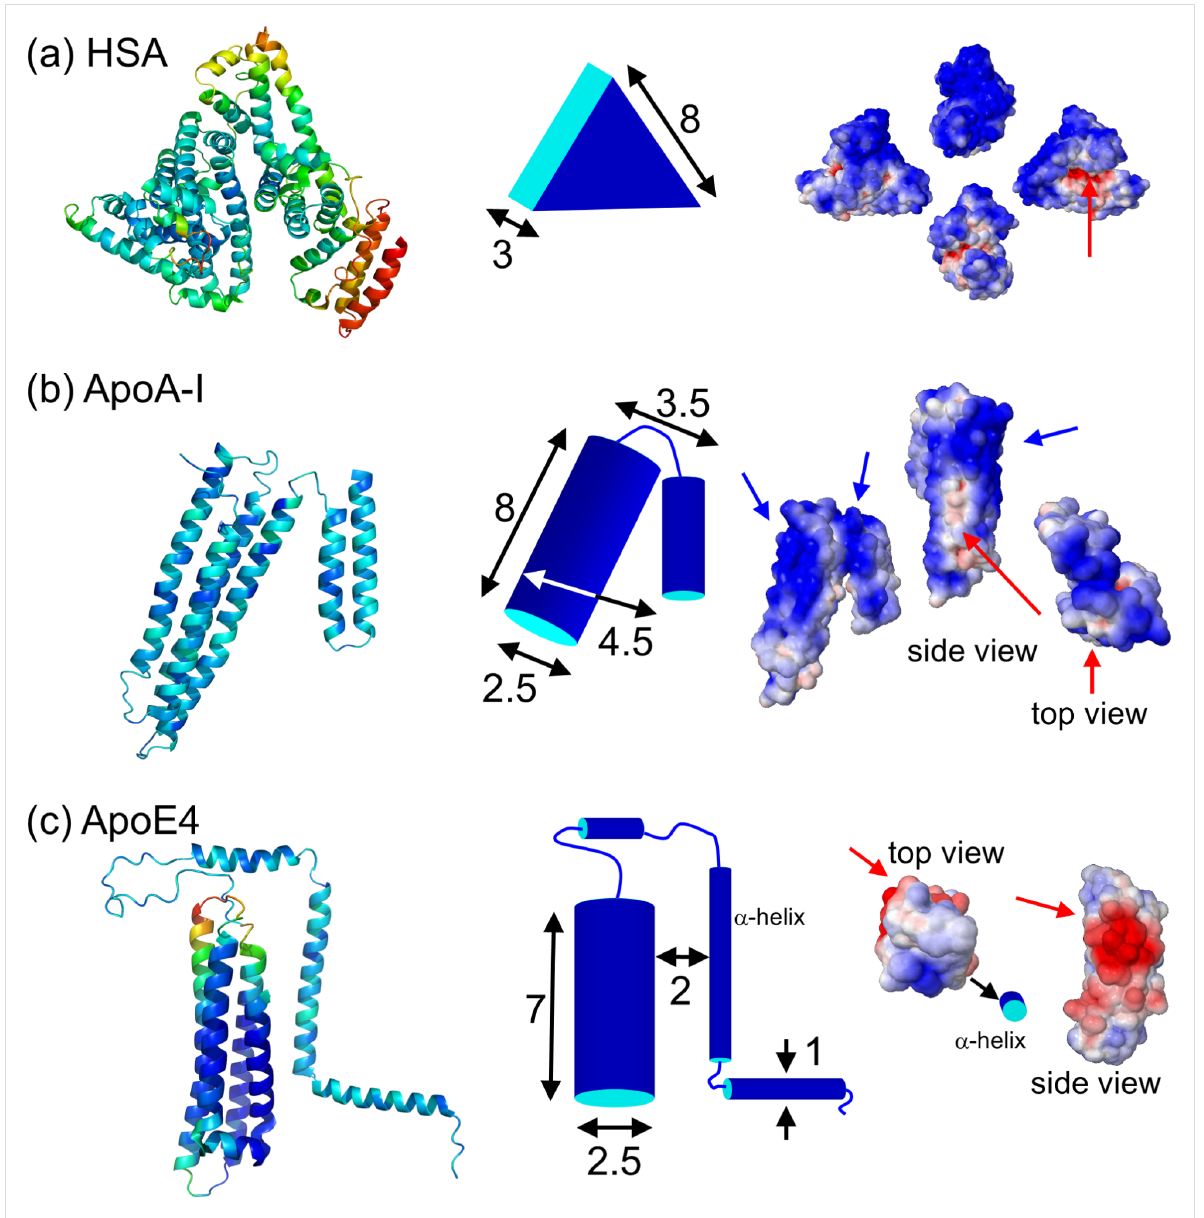
Figure 3: Structural depictions of (a) HSA, (b) apoA-I and (c) apoE4. Left column: Cartoon representations of HSA (protein data bank accession (pdb) code 1AO6), apoE4 (pdb code 1GS9) and apoA-I (pdb code 2A01). For apoE4, only the structure of the 22-K domain (4-helix bundle) has been solved. Center column: Simplified representations of the proteins including approximate dimensions (in nm). Right column: Space-filling models colored to indicate their surface electrostatics at pH 7.4 (blue: negative potential, red: positive potential; range from − 5 k B T/ e to +5 k B T/ e ; calculated online at http://kryptonite.nbcr.net/pdb2pqr/ [31]).